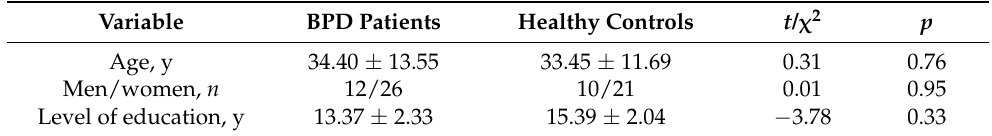
Table 1. Comparison (with a t test and χ 2 test) of the baseline values of demographic variables between the BPD and healthy control groups a .